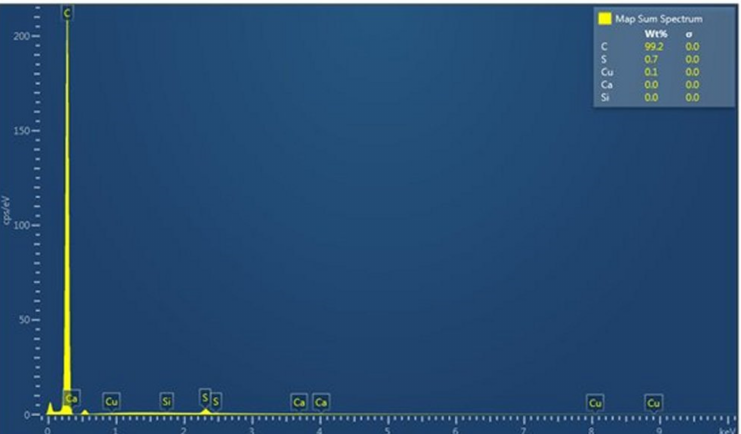
Figure 9. Chemical analysis from the point of analyzed waste. EDS.